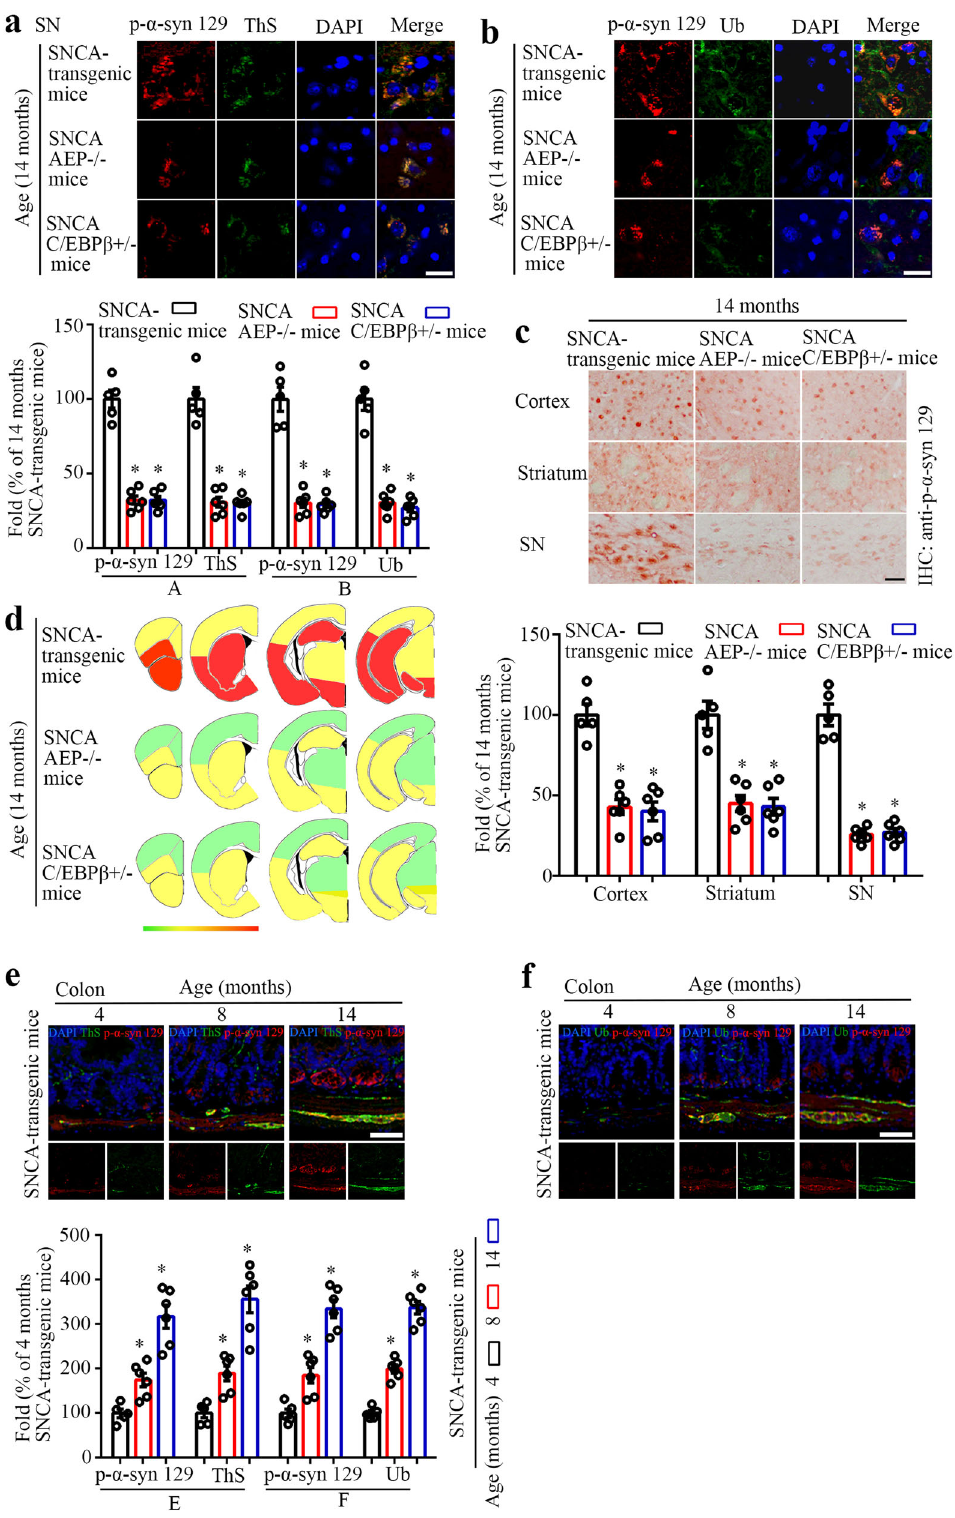
Fig. 4 C/EBP β /AEP signaling regulates Lewy body-like pathology in α -SNCA transgenic mice. Immuno fl uorescent co-staining of p- α -Syn 129 and ThS ( a ) and p- α -Syn 129 and Ub ( b ) in SN. Quanti fi cation of the immunostaining ( n = 5 – 6 per group, * P < 0.05 vs 14 months old α - SNCA transgenic mouse, one-way ANOVA). Scale bar, 20 μ m. c p- α -Syn 129 immunostaining of the cortex, striatum, and SN. Quanti fi cation of the IHC staining ( n = 5 – 6 per group, * P < 0.05 vs 14 months old α -SNCA transgenic mouse, one-way ANOVA). Scale bar, 50 μ m. d Heat map colors represent the extent of p- α -Syn 129 pathologies (white (0), no pathology; red (3), the maximal pathology). Immuno fl uorescent co- staining and the quanti fi cation of p- α -Syn 129 and ThS ( e ) and p- α -Syn 129 and Ub (f) in the colon. ( n = 5 – 6 per group, * P < 0.05 vs 14 months old α -SNCA transgenic mouse, one-way ANOVA). Scale bar, 50 μ